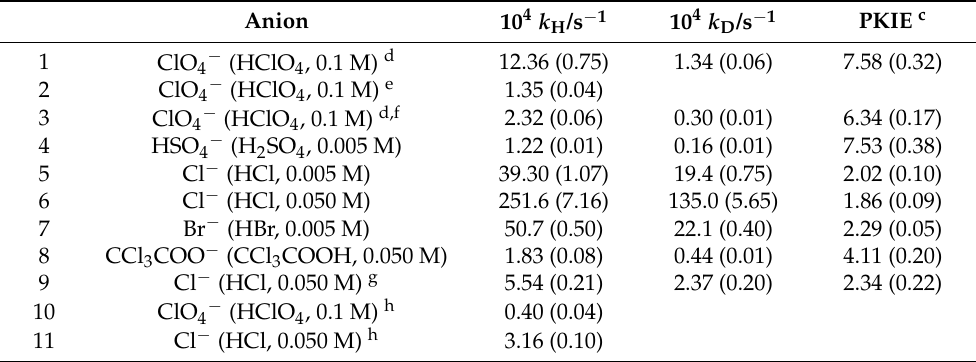
Figure 2. Transition structures for the proposed proton transfer from the nitrosocarbinolic cation C atom to a chloride ion in reaction step 2 → 3 within the corresponding 1 ,chloride contact ion pair ( TS-1 ) and to a water molecule within a corresponding 1 ,chloride solvent shared ion pair ( TS-w ) obtained from ab initio calculations. The Gibbs activation energy for reactions from the corresponding ion pair are +24.6 kJ mol − 1 and +56.0 kJ mol − 1 for TS-1 and TS-w , respectively. The normal mode displacement vectors shown (blue arrows) for the unique imaginary frequency of 946 i cm − 1 for transition structure TS-1 are associated with a motion of both the H atoms of the CH 2 moiety of the nitrosocarbinolic cation. In the case of TS-w, the normal mode displacement vector for the unique imaginary frequency of 1546 i cm − 1 is associated mainly with a motion of the H atom. Table 1. Influence of the particular anion on the observed rate constants and kinetic isotope effects in the reaction of aldehydes and nitrosobenzene a,b